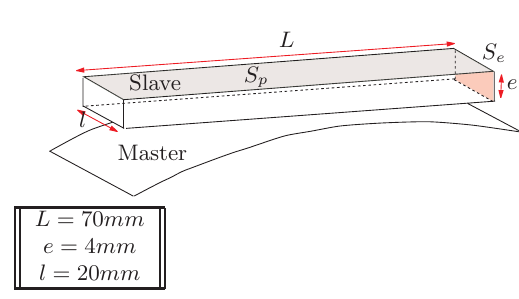
Fig. 11. Contact between a plate and a rigid cylinder: geometry.